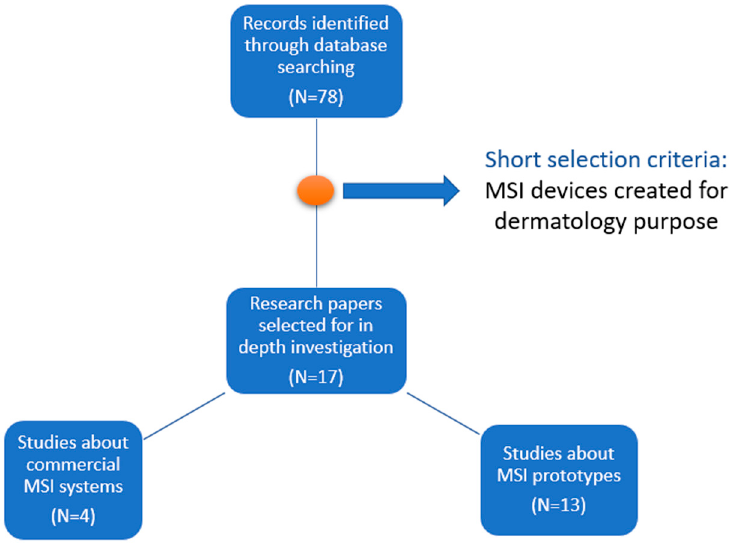
Figure 1. Flow diagram of the study selection process included in this review.